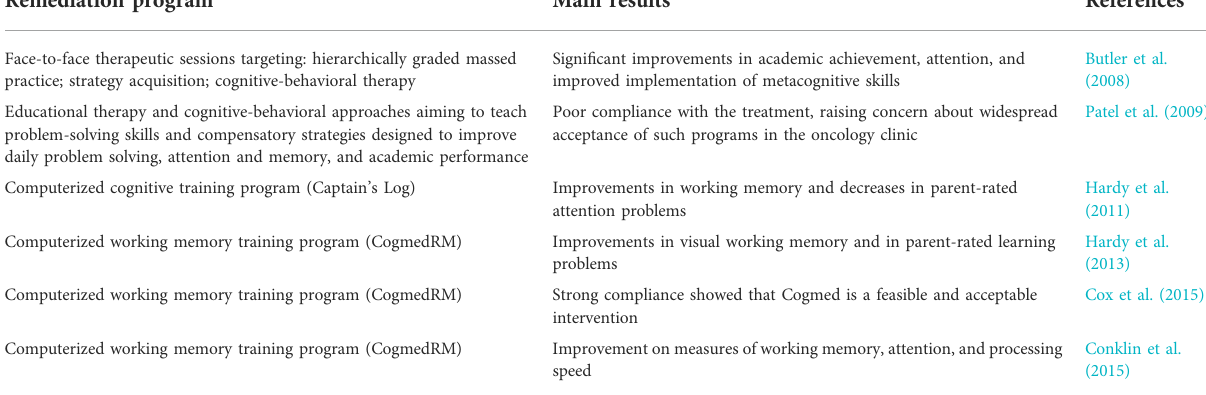
TABLE 3 Main cognitive remediation programs are summarized. Two distinct approached are utilized: face-to-face therapeutic sessions, and computer-based intervention. None of these studies focuses on children affected by pCMS. Remediation